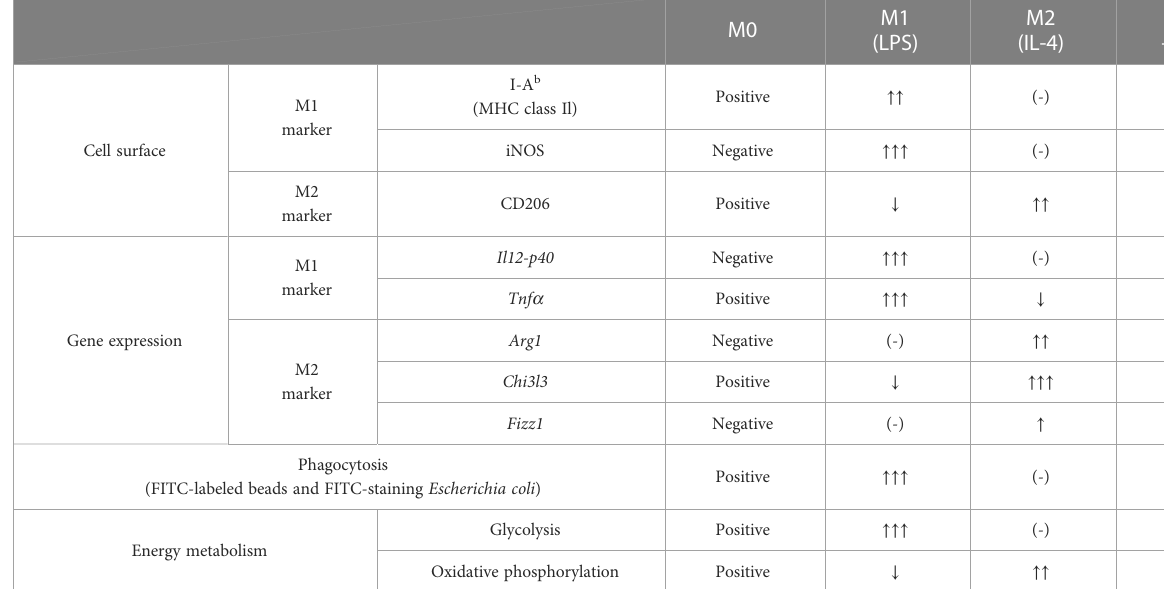
TABLE 1 Summary of LPS/IL-4-induced macrophage features.